Question: What caption would you write for this figure?
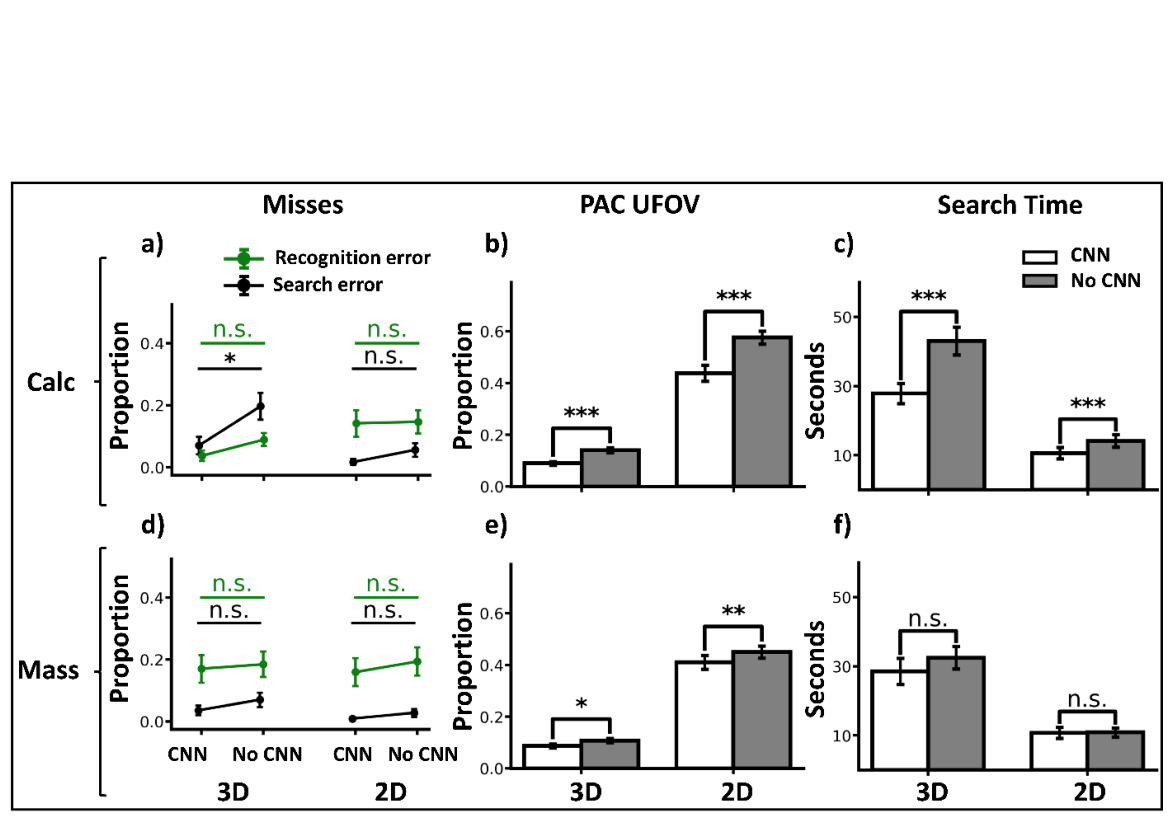
Answer: Additional measures exemplify the impact of the CNN-CADe on the participant's search strategies. a) The mean proportions of  microcalcification search errors (black lines) and recognition errors (green lines) in 3D (left set of lines) and 2D (right set of lines). For a given  line, the left scatter point represents a particular mean error rate when observers searched for the microcalcification with the CNN-CADe, and  the right scatter point represents that same endpoint but when observers searched for the microcalcification without the CADe available. b) The  mean proportion of the search area (PAC) covered by the standard UFOV (2.5 dva radius) on all trials for the 3D (left cluster of bars) and 2D  (right cluster of bars) searches. White bars denote the area covered when searching for the microcalcification signal with the CNN-CADe, and  gray bars represent the proportion of the area covered when searching for the microcalcification without the CNN-CADe. c) The mean search